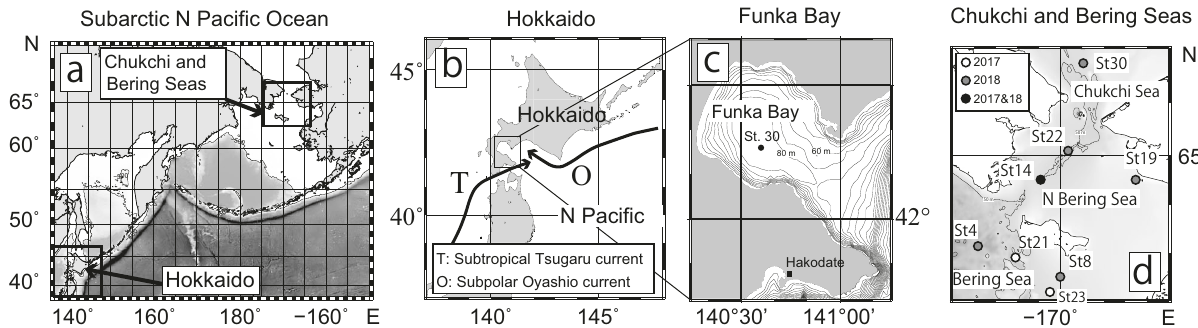
Fig. 1 Sampling sites. a Map of North Paci fi c including study areas. b Map of Hokkaido Island in Japan. c Sampling site of Funka Bay in Hokkaido, Japan. Black circle indicates the station 30. d Sampling sites of Chukchi and Bering Seas. White and gray circles indicate sampling sites in 2017 and 2018, respectively. Black circle indicates a common sampling site in 2017 and 2018. Northern Bering Sea stations and Bering Sea stations are 14, 19, 22 and 4, 8, 21, 23 respectively. Video recordings of the sea fl oor were taken at station 30 in Funka Bay and at stations 4, 8, 14, and 22 in the Bering Sea (Supplementary Movie 1 – 4,